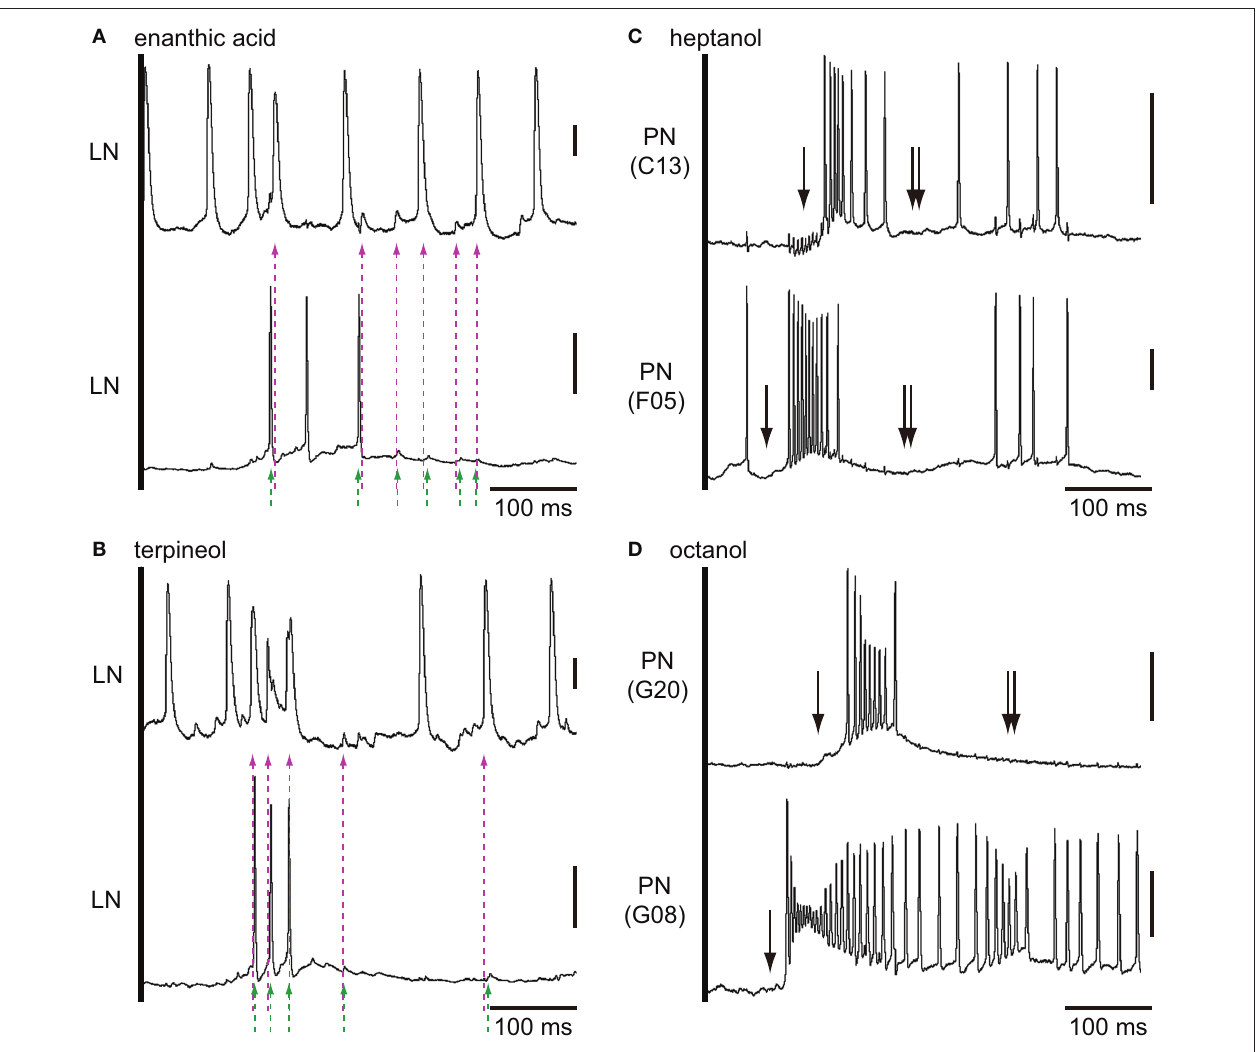
excitatory responses of two different projection neurons arborizing G8 and G20 glomeruli. Both couples of projection neurons exhibited strong excitatory responses to the given odorants with different latencies. Projection neurons exhibited characteristic biphasic (IPSP-EPSP) or triphasic (IPSP-EPSP-IPSP) olfactory responses. The triphasic response consists of a phasic IPSP (single arrows), followed by an EPSP involving many action potentials. And, another hyperpolarizing phase (double arrows) follows EPSP prevented the PN from firing for 100–300ms. Vertical bars =